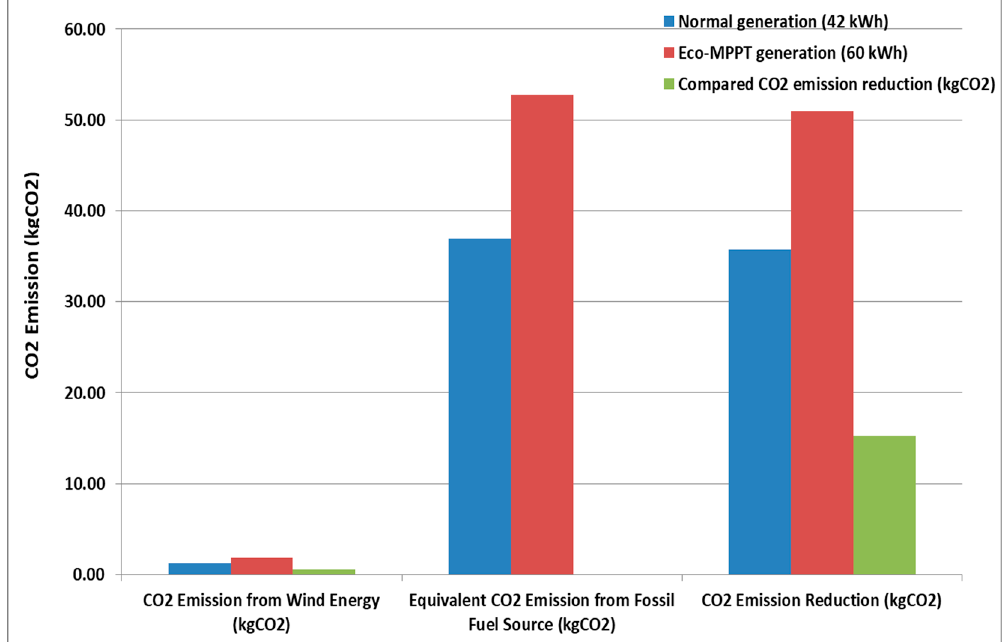
Figure 18. The CO 2 emission and reduction in normal and Eco-MPPT cases compared to fossil fuel case.